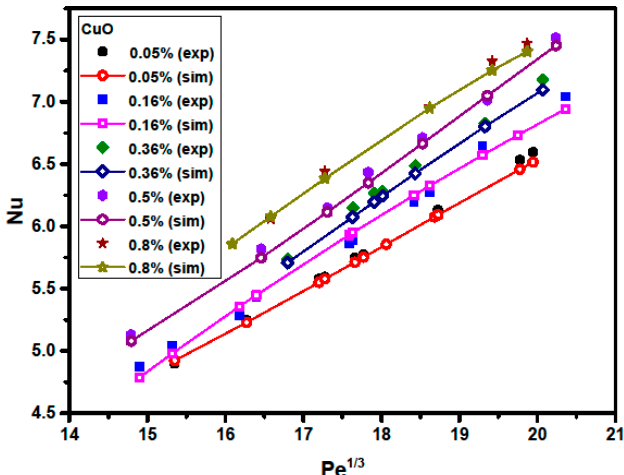
Figure 9. Comparison between numerically-predicted and experimentally-measured Nusselt number at various particle volume concentrations and Pe values for CuO/water nanofluids.